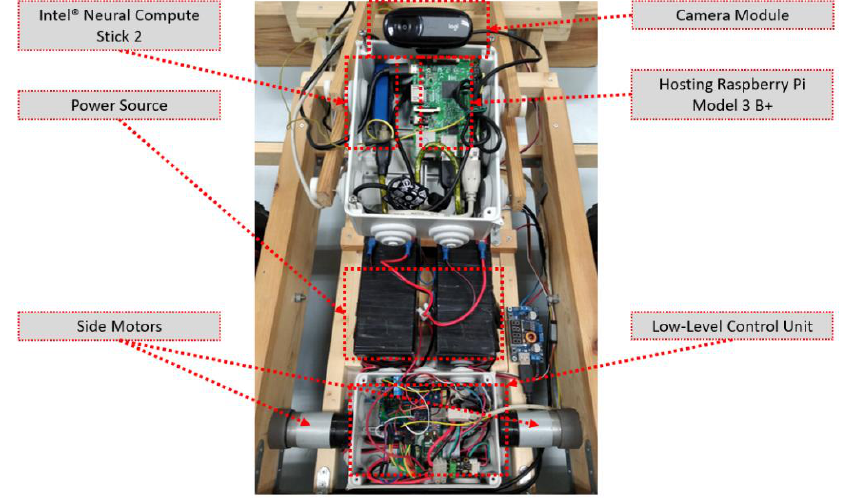
Figure 8. Details of the core engine of the robot presented in [145].